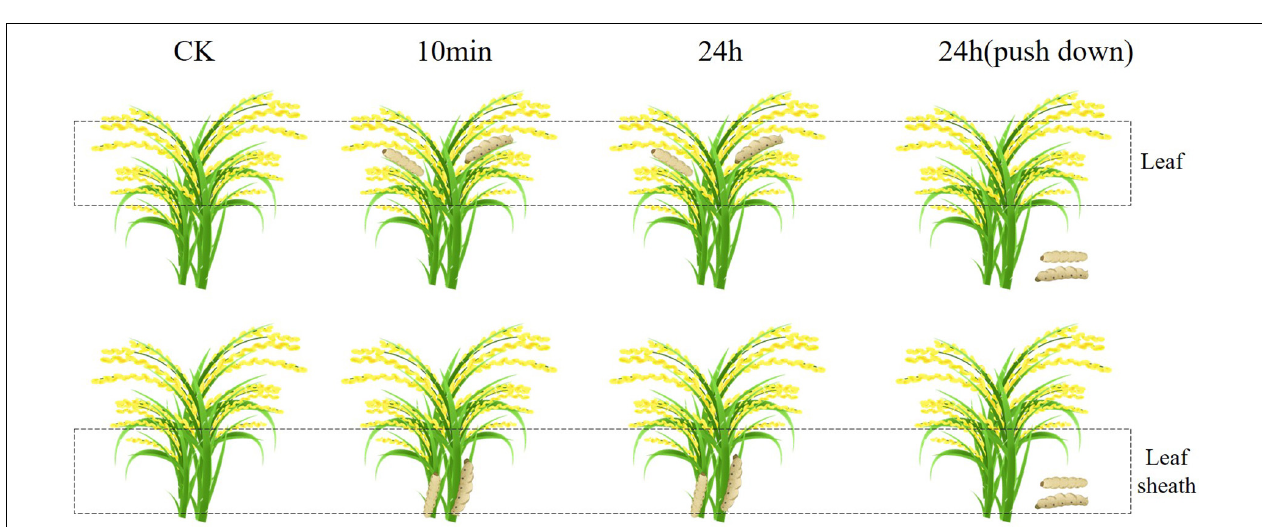
FIGURE 5 | SVs affecting the conserved domains of TPSs. (A) The conserved domain sequence logos of TPSs from reference (left) and Basmati1 (right) genomes. The dotted line represents the correspondence between Basmati1 and the reference genome. The 10 conserved domains are arranged in ascending order of E -values. (B) The typical and atypical TPS genes in each accession. The word “both” represents that there were both typical and atypical genes in each accession.